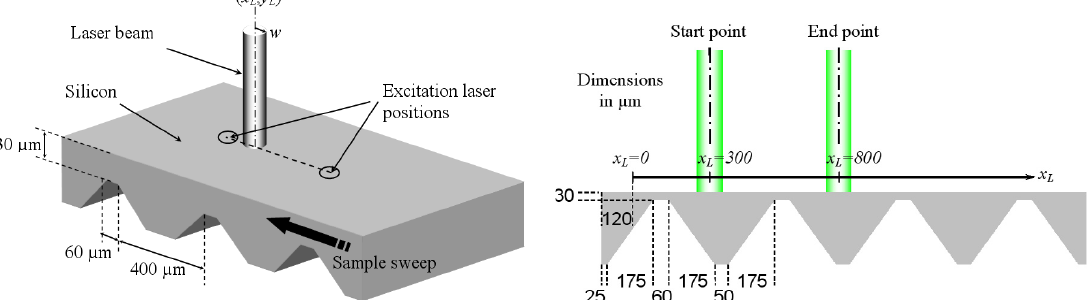
Fig. 1. Geometry of the silicon sample and 3D modeling strategy.